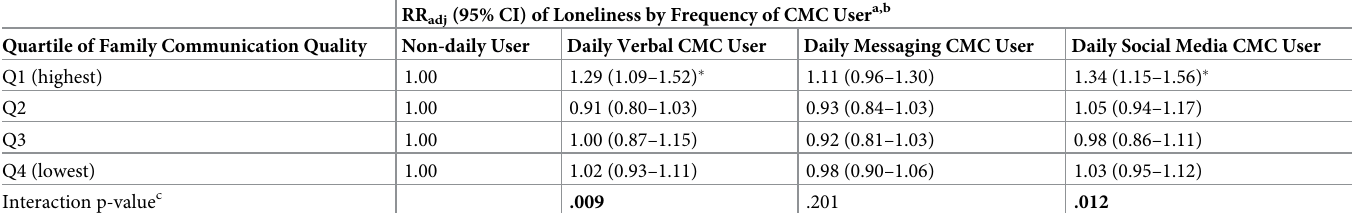
Table 4. The association between non-daily and daily CMC use and loneliness by each quartile of self-perceived family communication quality as reported by Cana- dian adolescents (n =